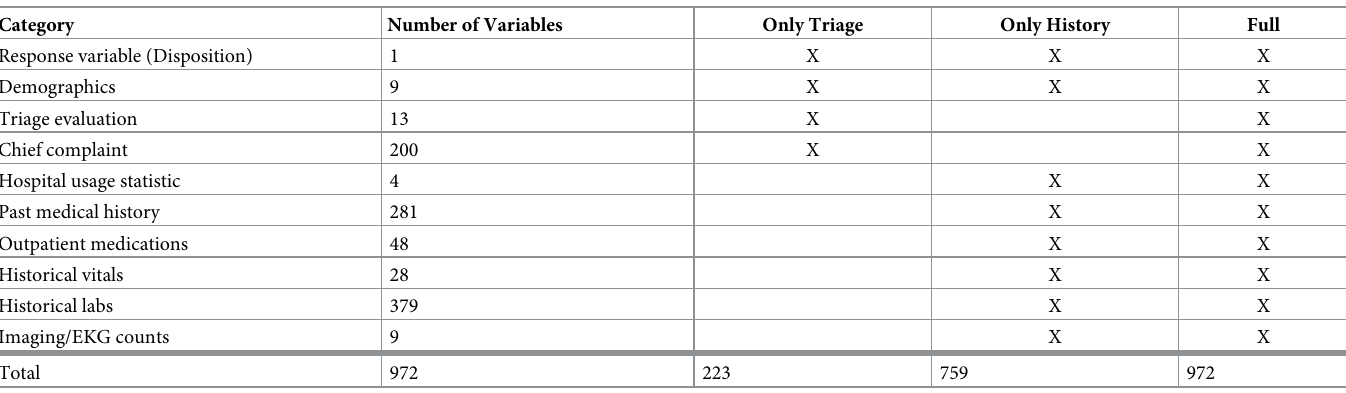
Table 1. Variables included in